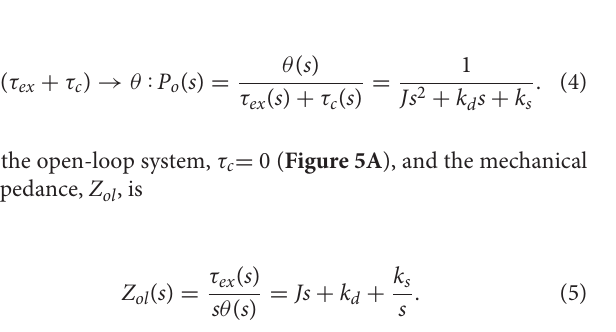
The transfer function of the spring-damper system, P o , which links the applied torque to the joint position θ ,